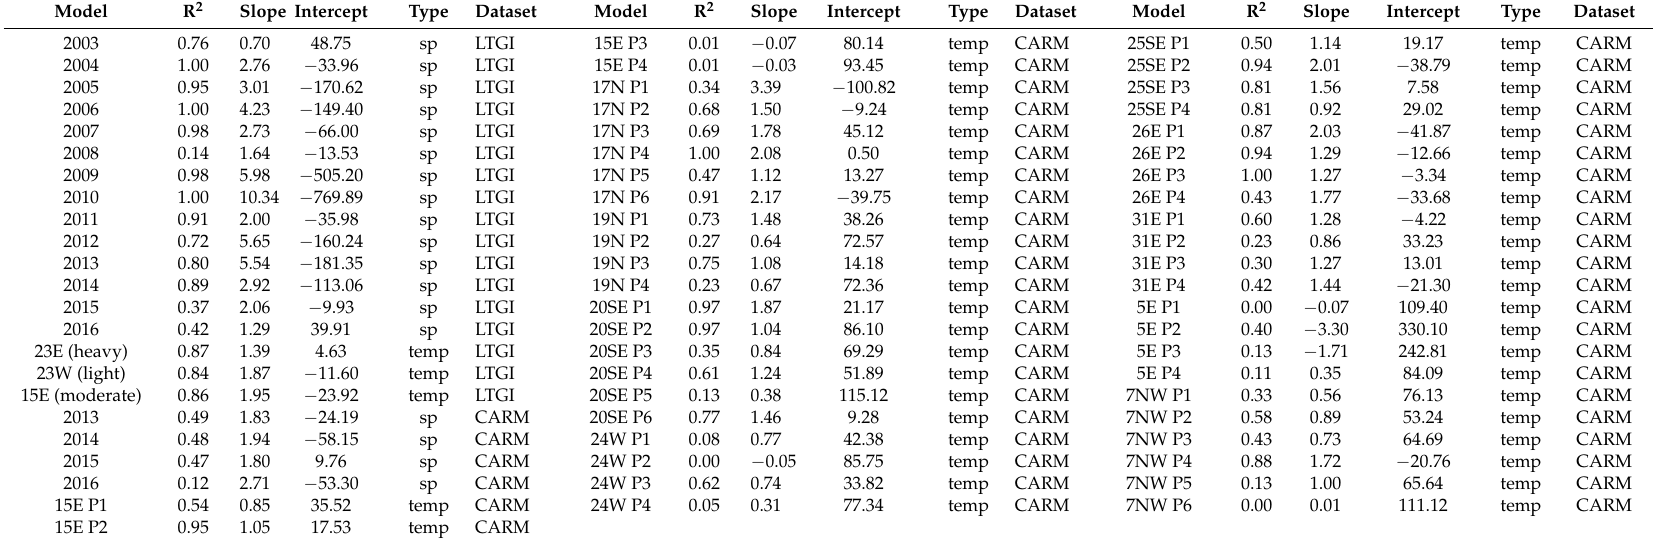
Table 1. Model results from the spatial and temporal linear regressions of ANHP on iAPAR for the LTGI and CARM experiments. In the “Type” column, sp = spatial model and temp = temporal model. The “Model” column refers to the year (for spatial models) or pasture/plot for temporal models.